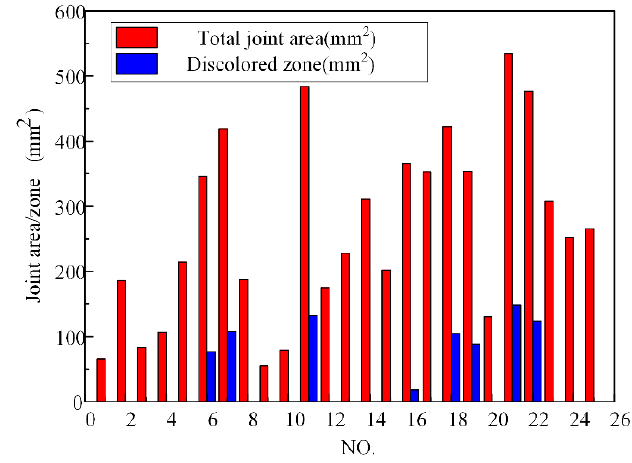
Figure 12. Orthogonal experimental design results of the 25 conditions: measured total joint area and discolored zone.